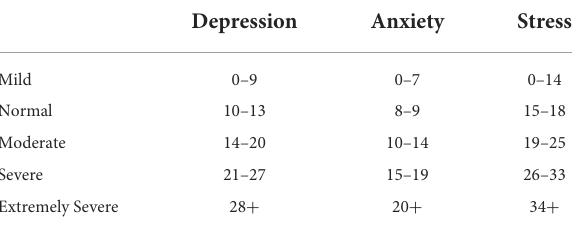
TABLE 1 The DASS 21 recommended cut-off points (7). TABLE 2 Sociodemographic characteristics of the participants